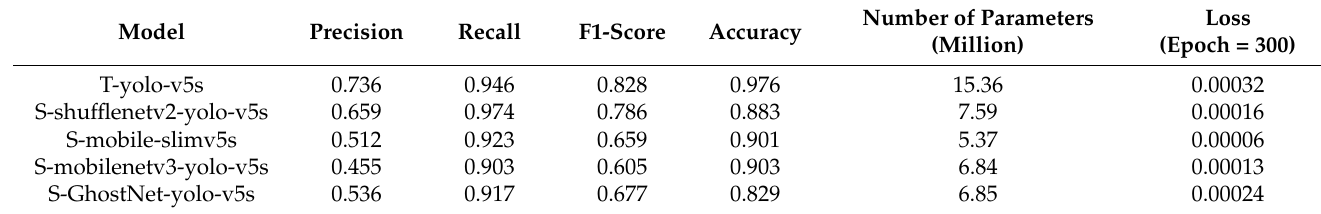
Table 4. Performance comparisons.